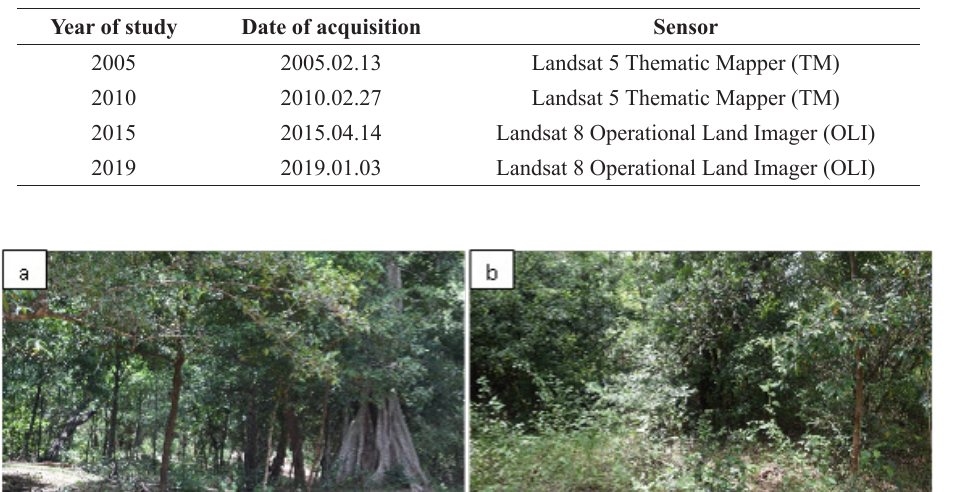
Table 1: Dates of acquisition of satellite images from the relevant sensors.